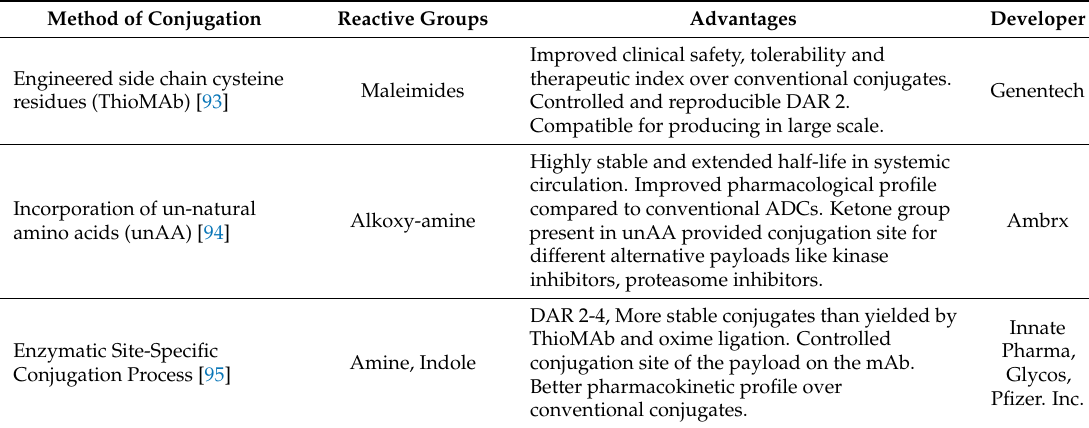
Table 2. Comparison between different site-specific conjugation